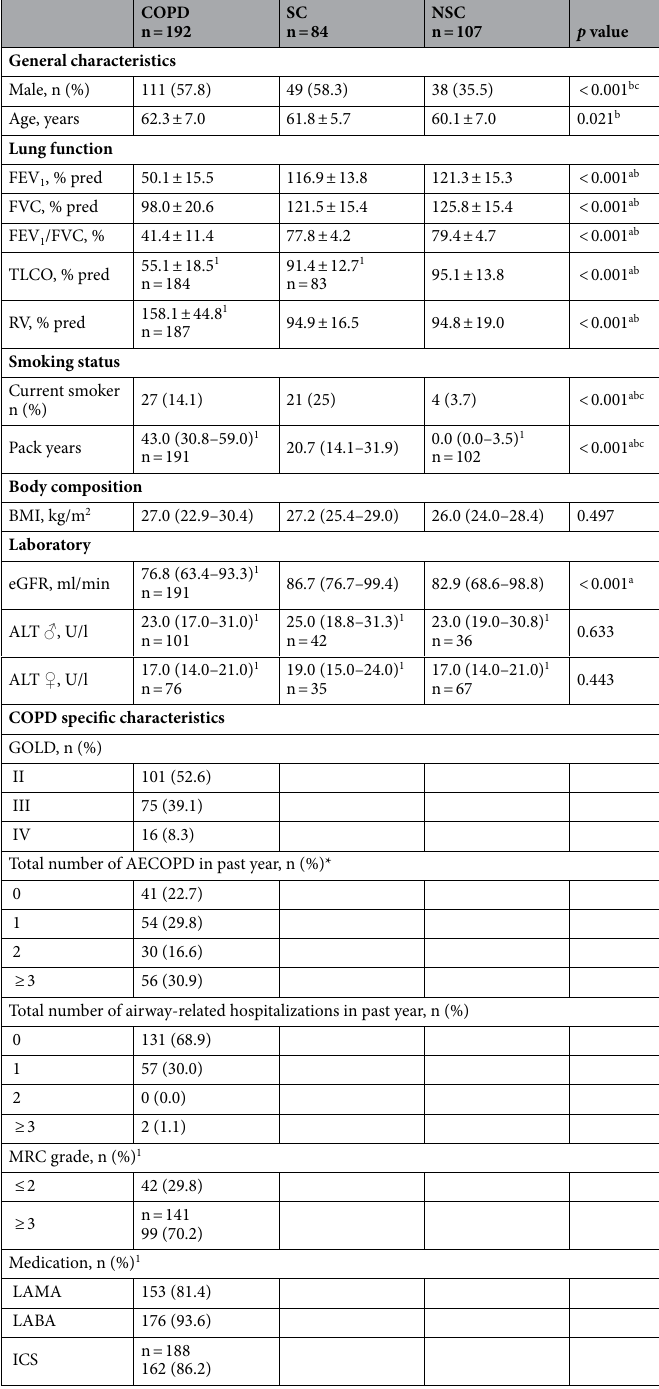
Table 1. Baseline clinical characteristics of the 192 patients with chronic obstructive pulmonary disease (COPD), 84 smoking controls (SC) and 107 non-smoking controls (NSC). Variables are presented as n (% n), mean ± SD and median (IQR) with overall p values. Abbreviations: AECOPD; acute exacerbation of COPD, ALT; alanine aminotransferase, BMI; body mass index, eGRF; estimated glomerular filtration rate, FEV 1 ; forced expiratory volume in 1 s, FVC; forced vital capacity, GOLD; global initiative for chronic obstructive lung disease, ICS; inhaled corticosteroid, LABA; long-acting β2 agonist, LAMA; long-acting muscarinic antagonist, MRC; medical research council, RV; residual volume, TLCO; transfer factor for carbon monoxide, % pred; % of predicted. * Mild to severe AECOPD. 1 n is stated otherwise. Significant post hoc pairwise comparison between a COPD-SC b COPD-NSC c NSC-SC. Post hoc comparisons are corrected for multiple